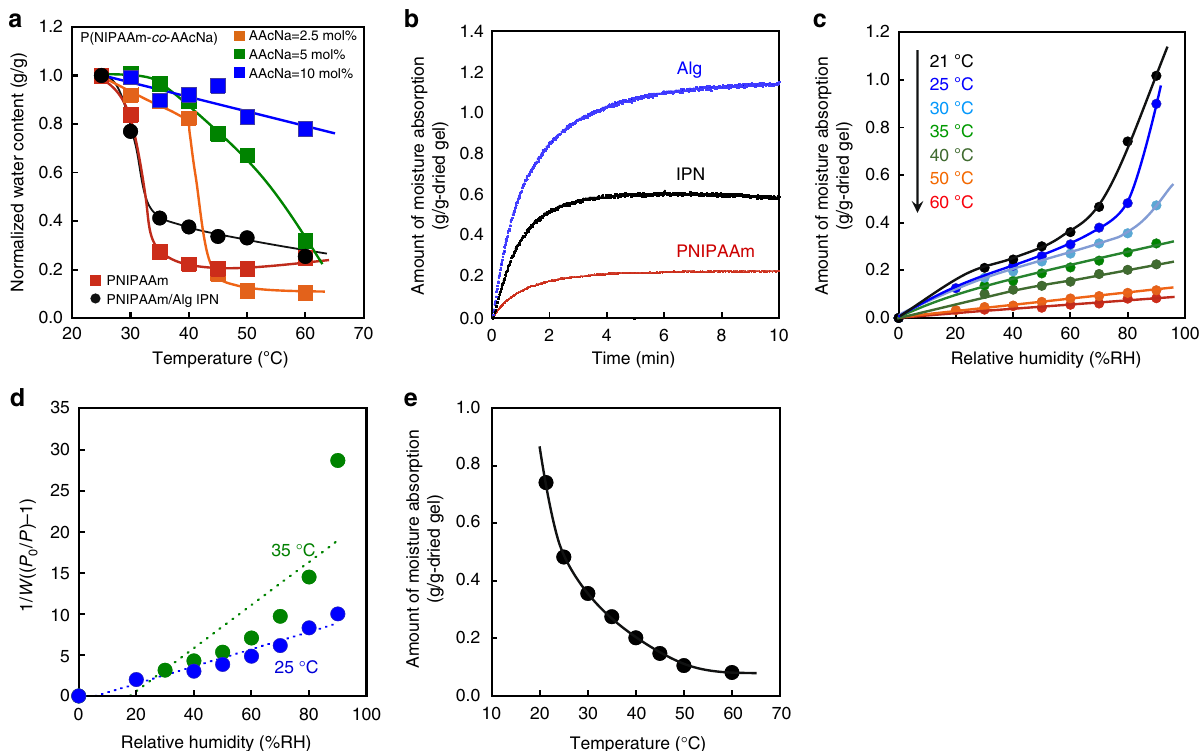
Fig. 2 Thermo-responsive behaviors of hydrogels and dried gels. a Relationship between temperature and normalized water content of PNIPAAm hydrogel, P(NIPAAm- co -AAcNa) hydrogels with an AAcNa content of 2.5, 5, and 10 mol%, and PNIPAAm/Alg IPN hydrogel in water. b Moisture-absorption kinetics of the freeze-dried IPN, the Alg, and the PNIPAAm gels at 27 °C and 80% RH. c Moisture-absorption isotherms of the IPN gels at various temperatures. d BET plots of the IPN gels at 25 and 35 °C. e The absorption capacity of dried IPN gels at 80% RH and various